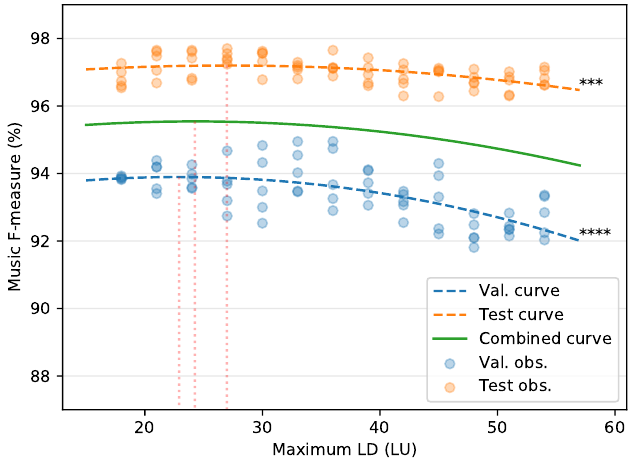
Figure 5. F-measure for different values of maximum loudness difference (LD). The minimum LD was fixed at 7 LU. Validation observations (Val. obs.) and test obs. are the actual values obtained in experiments. The val. and test curves were generated through quadratic curve fitting. The combined curve aggregates the observations on val. and test set for quadratic curve fitting. The vertical dotted lines in red indicate the maxima of the curves. ANOVA was performed on the observations and the asterisks indicate the level of significance (*: p < 0.05, **: p < 0.01, ***: p < 0.001, ****: p < 0.0001).